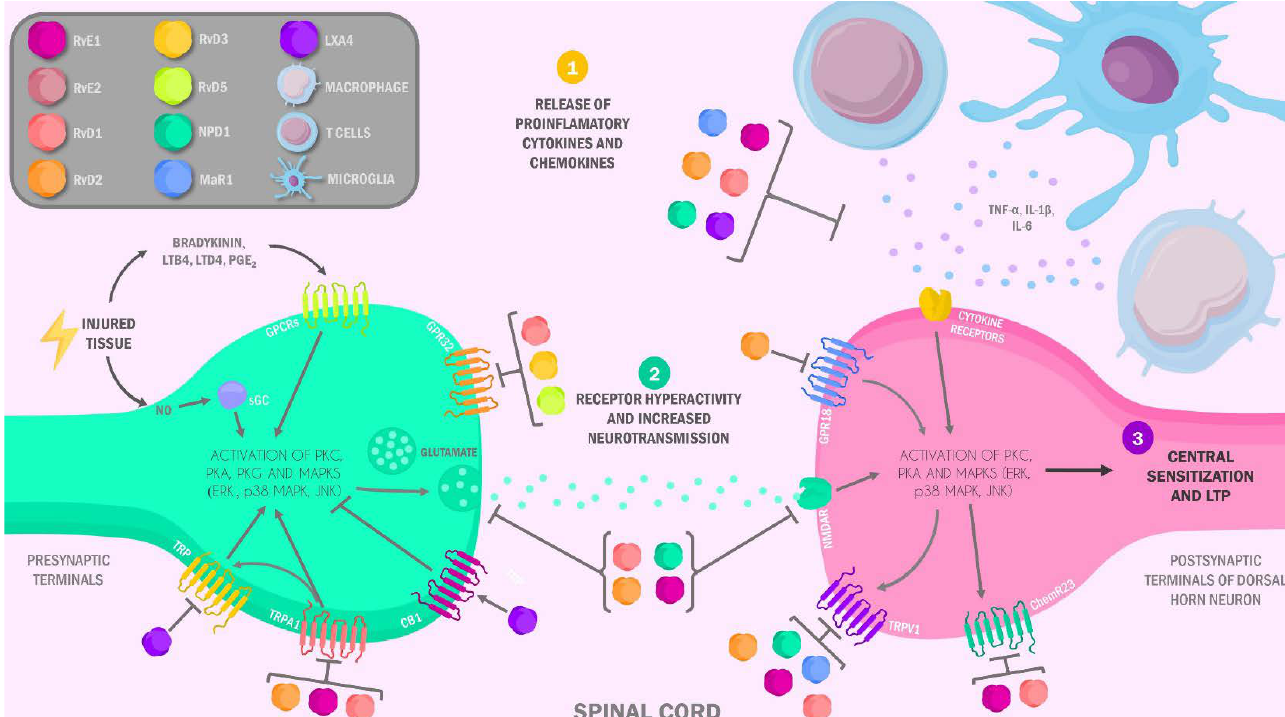
Figure 2. Role of specialized pro-resolving lipid mediators in central sensitization and long-term spinal potentiation in pain. Inflammation caused by local or peripheral injury impacts the nervous system through pro-inflammatory mediators secreted by immune and specialized cells, with the subsequent upregulation and hyperactivity of nociceptors and other receptors related to pain perception, leading to uncontrolled synaptic activity and development of central sensitization and long-term spinal potentiation. RvE1: resolvins E1; RvE2: resolvins E2; RvD1: resolvins D1; RvD2: resolvins D2; RvD3: resolvins D3; RvD5: resolvins D5; NPD1: neuroprotectins 1; MaR1: maresins 1; LXA4: lipoxins A4; LTB4: leukotriene B4; LTD4: leukotriene D4; PGE2: protaglandines E2; GPCRs: G protein-coupled receptors; TRP: transient receptor potential; TRPV1: transient receptor potential vanilloid subtype 1; TRPA1: transient receptor potential cation channel subfamily A member 1; CB1: cannabinoid receptor 1; NMDAR: N-Methy-D-Aspartate Receptor; ChemR23: chemerin receptor 23; LTP: